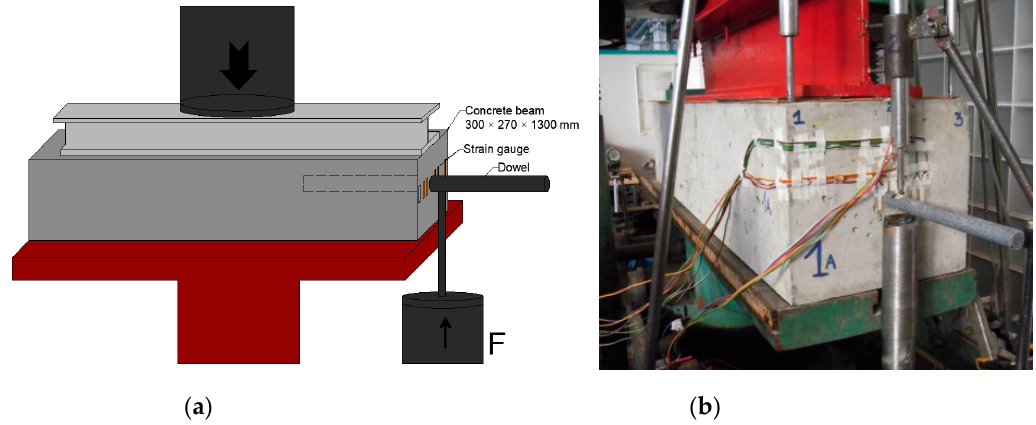
Figure 7. Slovak testing: ( a ) static loading test scheme and ( b ) real loading test.